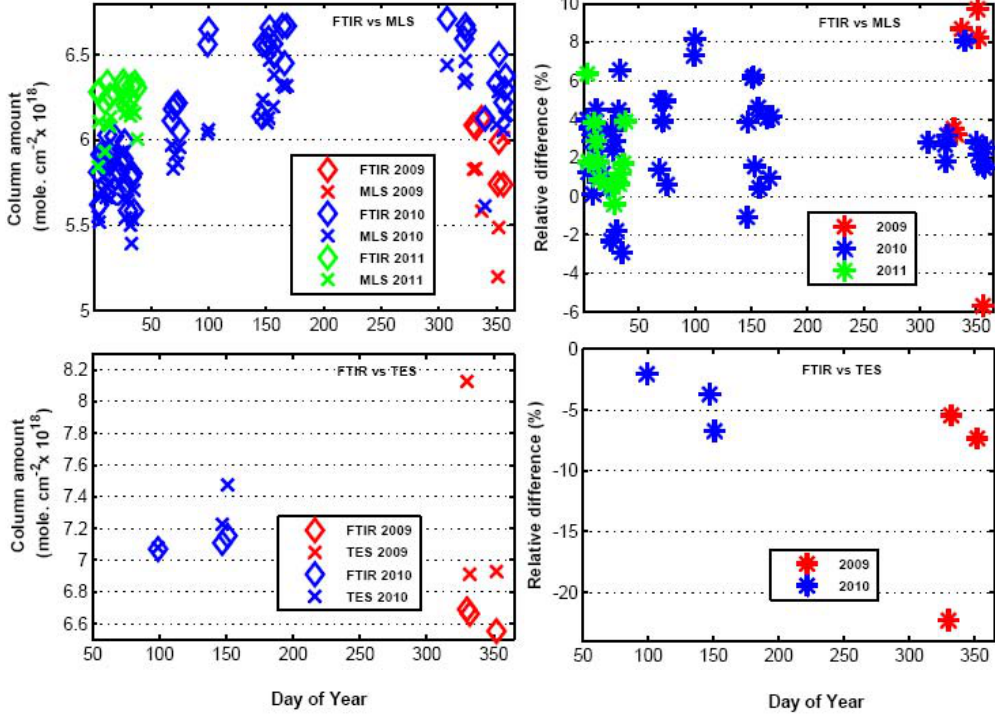
Fig. 7. Top-left panel shows column amounts of O 3 for FTIR (open diamonds) and the corresponding MLS measurements (cross) for different observations years (in colour), bottom-left panel shows column amounts between FTIR (open diamonds) and TES (cross). Right panels depict the relative differences between FTIR and MLS (right top panel), FTIR and TES (right bottom panel).